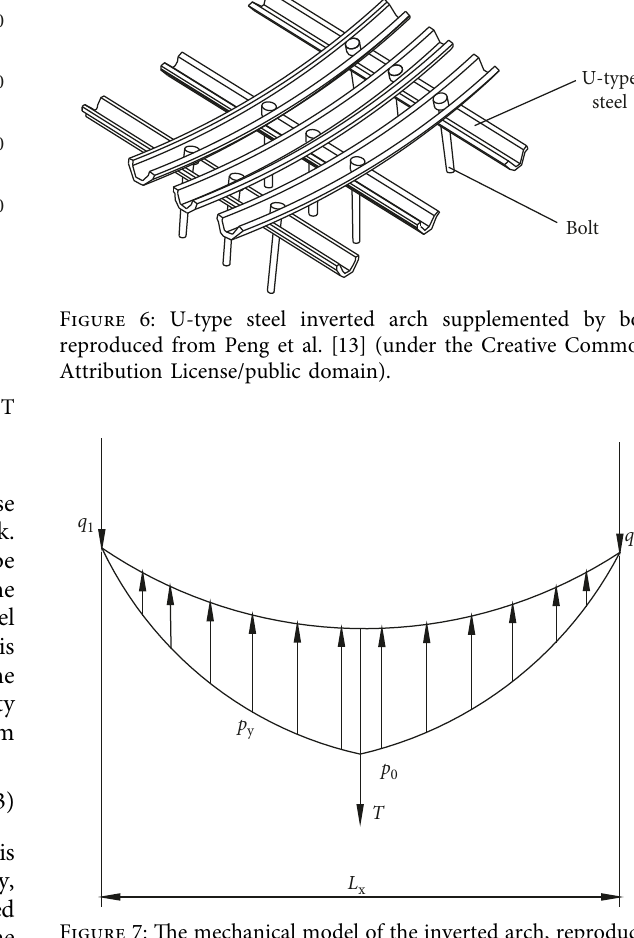
Figure 7: The mechanical model of the inverted arch, reproduced from Peng et al. [13] (under the Creative Commons Attribution License/public domain).